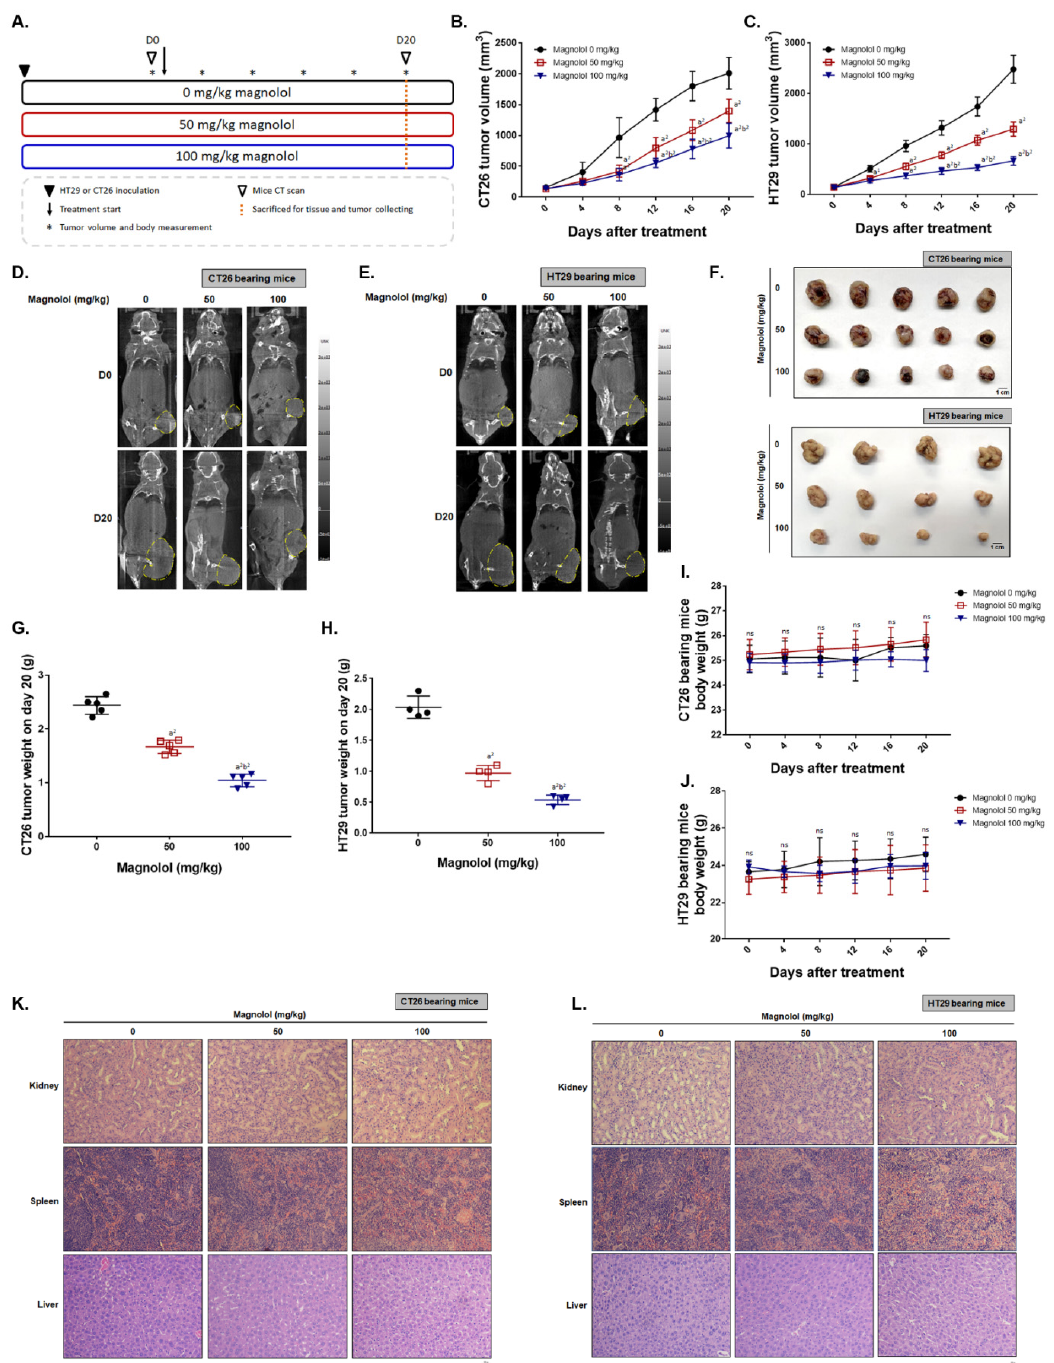
Figure 5. CRC growth is suppressed by magnolol treatment as dose-dependent manner. ( A ) Experimental flow chart of CT26 and HT29 bearing mice. Treatment is started after 3 weeks of tumor inoculation, and tumor volume reached average 100 mm 3 . ( B , C ) Tumor volume, ( D , E ) CT scanning images, ( F ) isolated tumor images, ( G , H ) isolated tumor weights, and ( I , J ) body weights in CT26 and HT29 bearing mice. ( K , L ) One represented pathology image of kidney, spleen and liver from each group. (a 2 p < 0.01 vs. 0 mg / kg magnolol; b 2 p < 0.01 vs. 50 mg / kg magnolol).